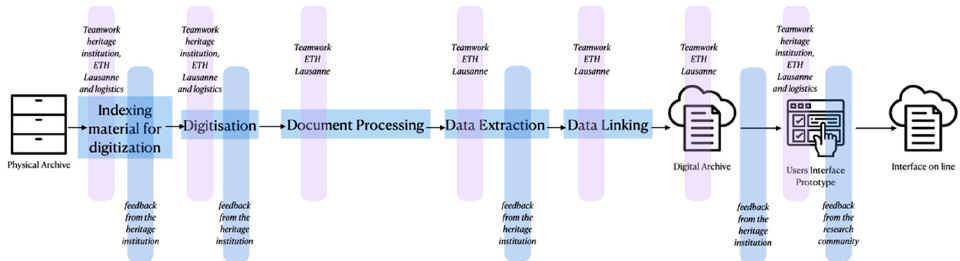
Figure 1. Replica Project General Pipeline (author: Isabella di Lenardo).